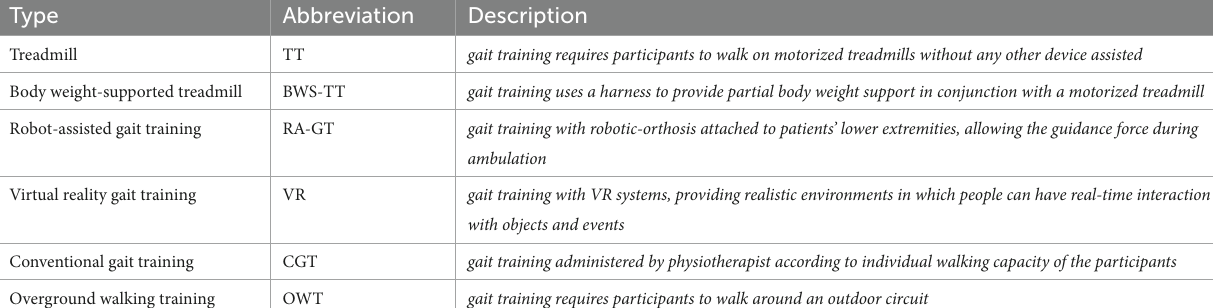
TABLE 1 Characteristics of included gait